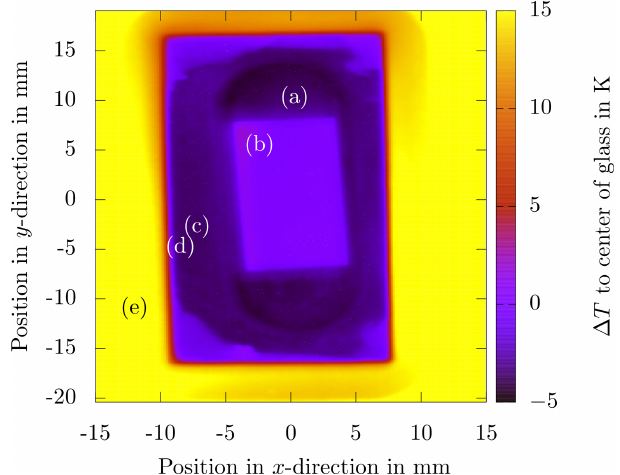
Figure 3. Infrared thermography image of the sapphire substrate placed inside the ceramic during the cool-down phase at a cooling rate of ˙ T = 5Kmin − 1 . The data represent the temperature differ- ence at each position with respect to the temperature of the sap- phire substrate in the image center ( 0 , 0 ) . Note the homogeneous temperature distribution in all parts, which are (a) bottom of the ce- ramic groove ( (cid:49)T ≈ − 3 . 8K), (b) sapphire substrate ( (cid:49)T ≈ 0K), (c) top surface of the ceramic ( (cid:49)T ≈ − 3 . 7K), (d) sealing between the PMMA (polymethylmethacrylate) cover sheet and ceramic body ( (cid:49)T ≈ 5K), and (e) PMMA cover sheet ( (cid:49)T ≈